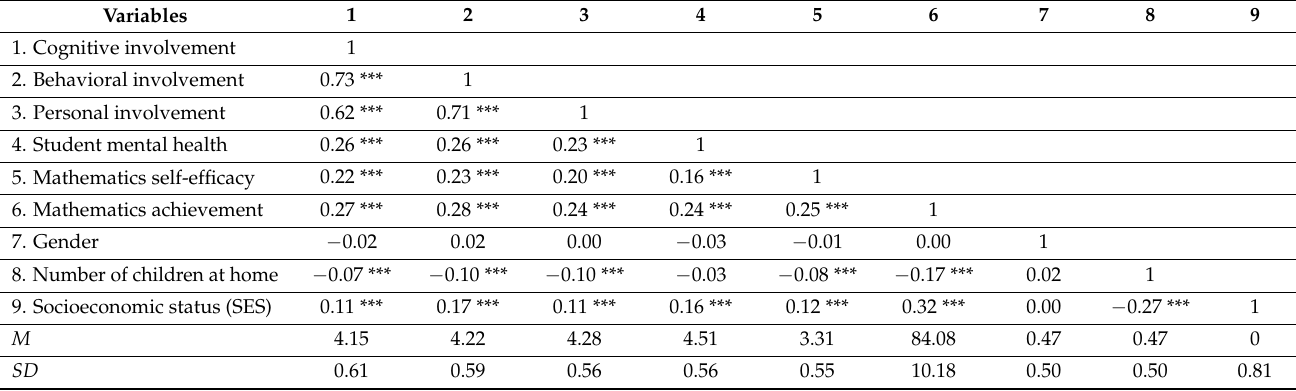
Table 1. Means ( M ), standard deviations ( SD ), and bivariate correlations of the study variables ( N = 2866).